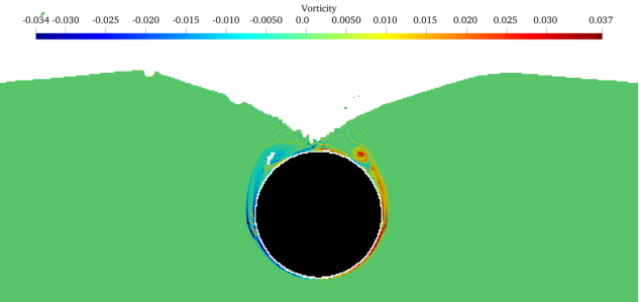
Figure 14. Vorticity profile for KBC method when the obstacle is completely submerged at t (cid:63) = 2.4850 for Fr = 0.5772.